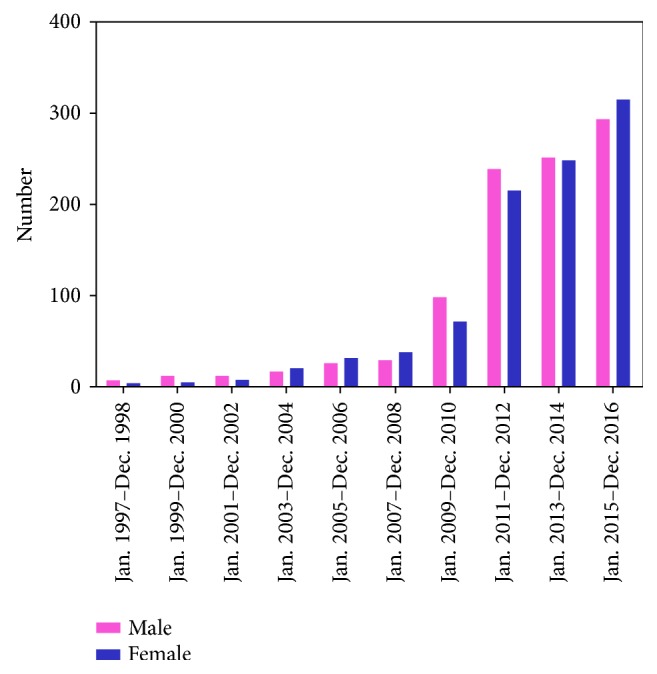
The distribution of patients according to the year.